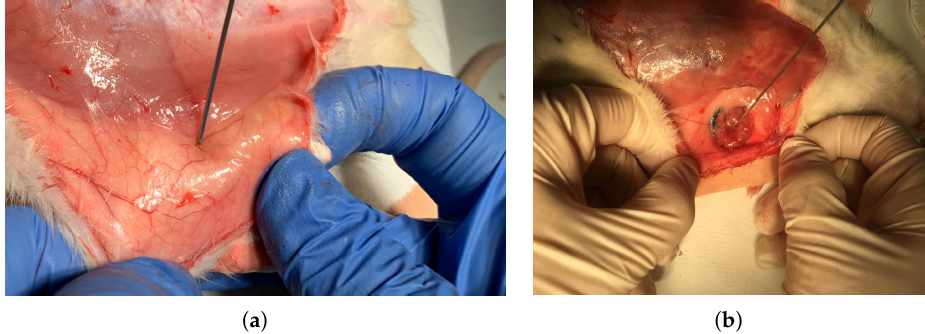
Figure 2. In vivo dielectric property measurements : ( a ) Measurement collected from the healthy breast tissue and ( b ) measurement of the malignant breast tumor tissue.